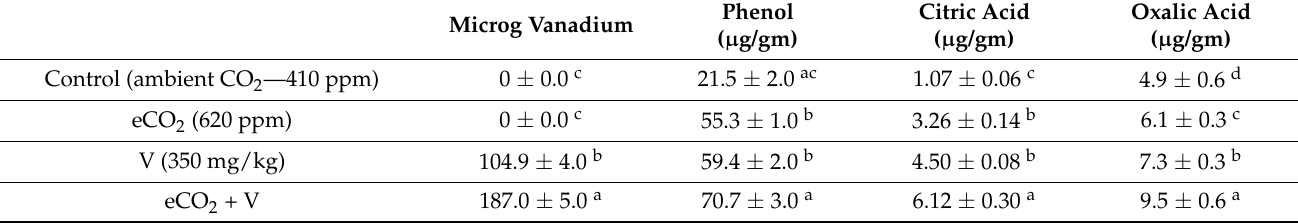
Table 2. Effect of elevated CO 2 (eCO 2 ), vanadium (V) and their combination (eCO 2 + V) on vanadium, citric acid and oxalic acid in soil. Data are mean values ± SE ( n = 4). Using Fisher’s LSD test, the data for each group were compared pairwise ( p < 0.05; n = 4). Different letters indicate that there is a significant difference between the